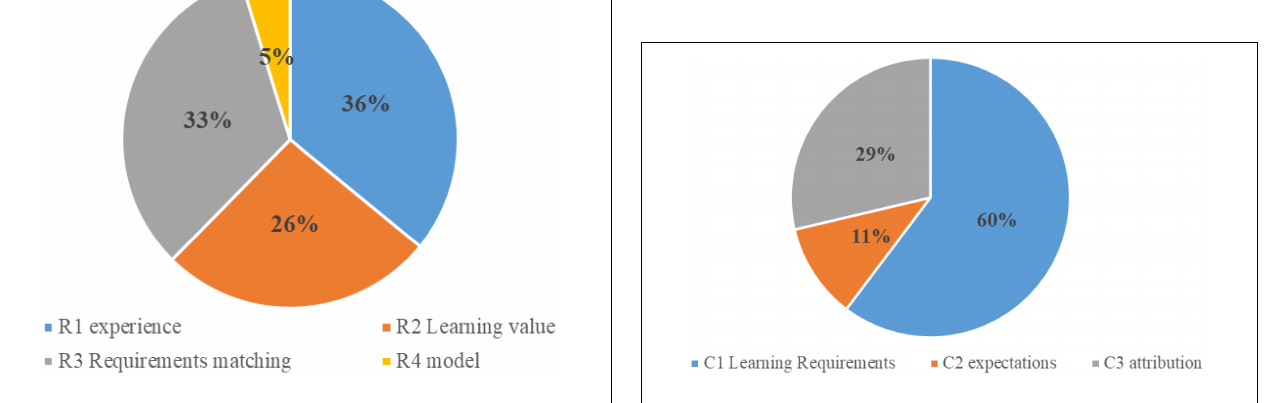
FIGURE 2 | Percentage of secondary strategy usage in relevance strategy. FIGURE 3 | Percentage of secondary strategy usage in confidence